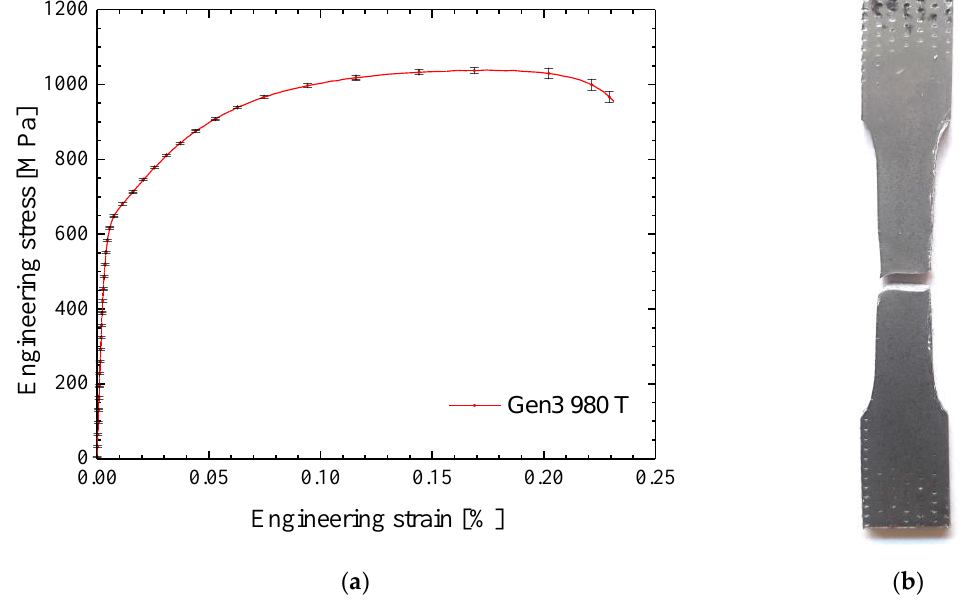
Figure 3. ( a ) Engineering stress vs. strain curve of Gen3 980T steel, and ( b ) sample without welding after the tensile test.